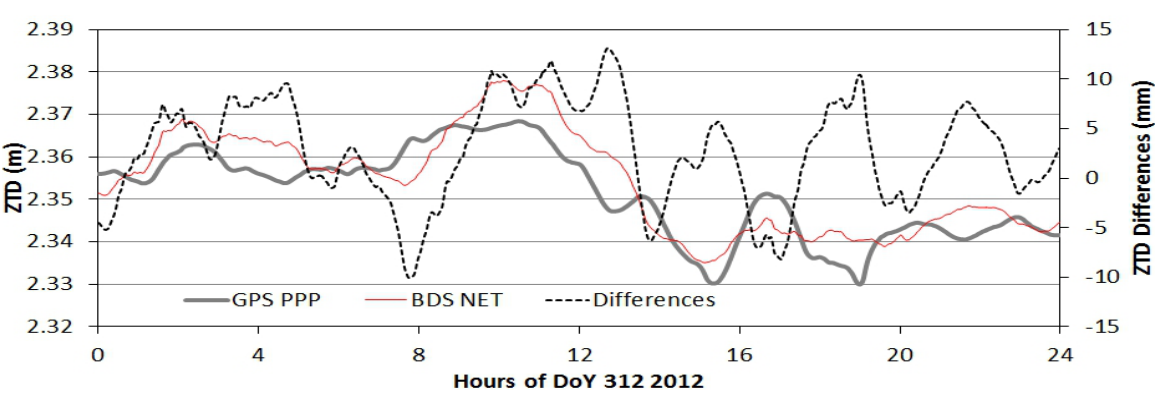
Figure 8. Comparison of ZTD derived from GPS data in PPP mode and from BDS data in network mode. The differences (BDSNET-GPSPPP) are within +/ − 10 mm with a bias of about 3 mm.